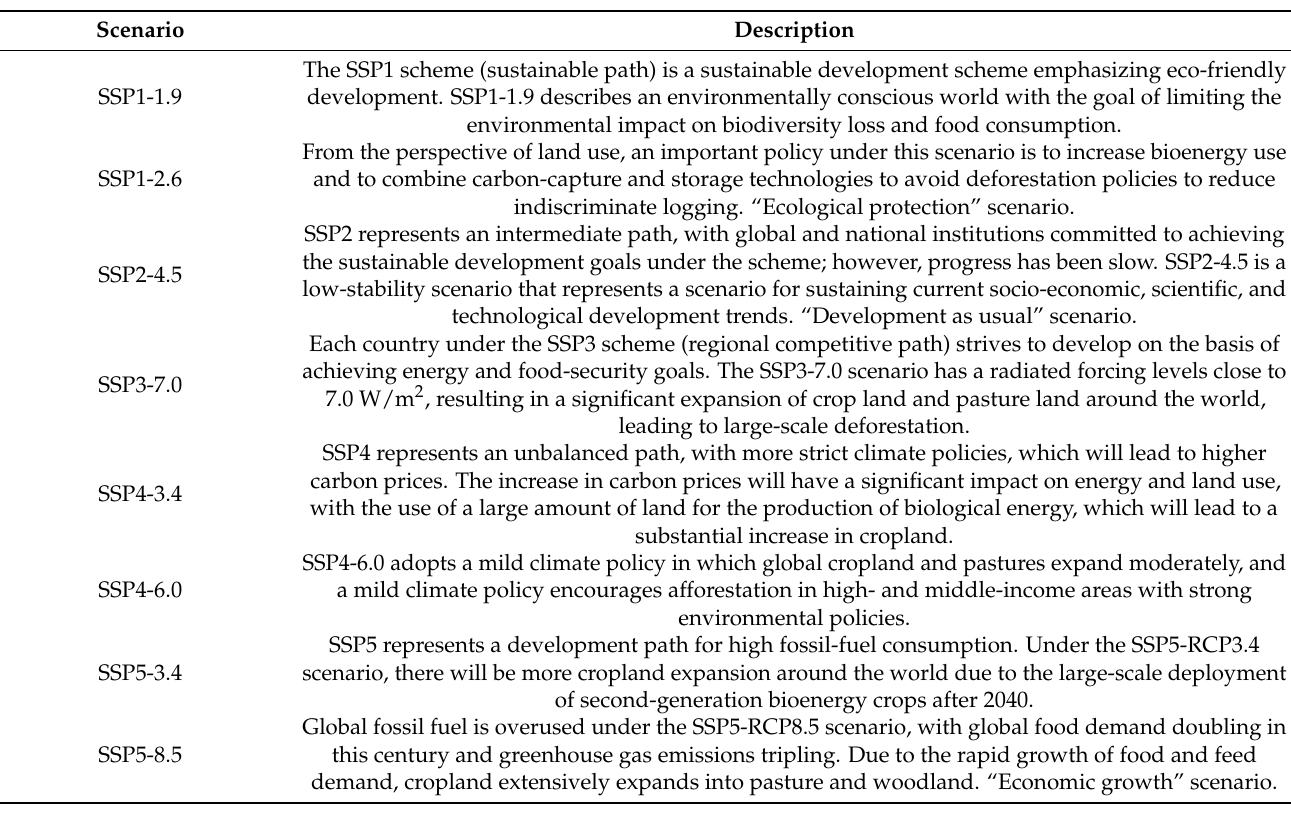
Table 2. Description of SSP-RCP